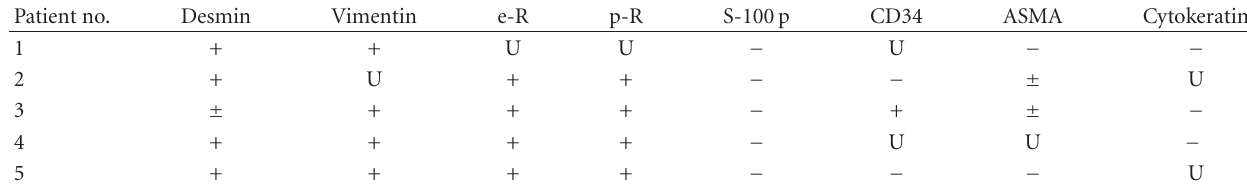
Table 2: Immunohistochemical staining for the most common antibodies in the